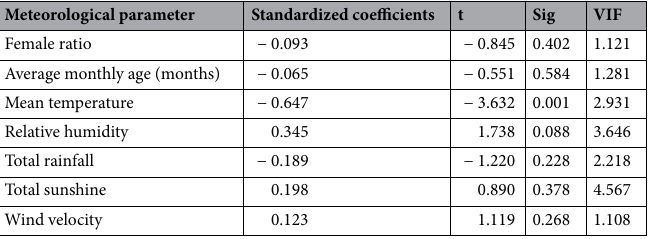
Table 4. Correlation between meteorological factors and wheezing diseases in children. Dependent variable: number of wheezing diseases, t: t value, sig: significance. VIF: variance inflation factor.